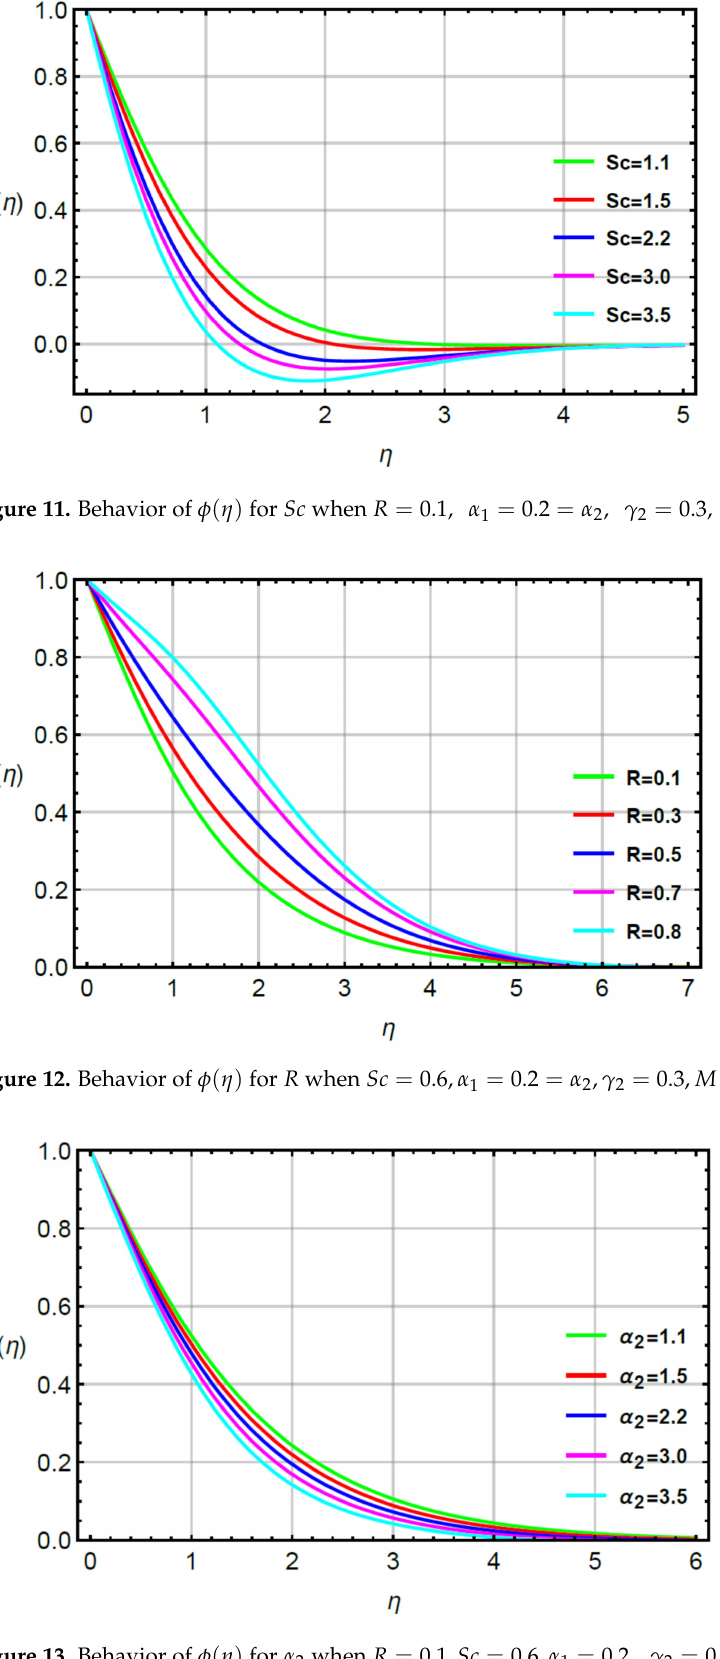
Figure 13. Behavior of φ ( η ) for α 2 when R = 0.1, Sc = 0.6, α 1 = 0.2, γ 2 = 0.3, M = 0.1, δ =